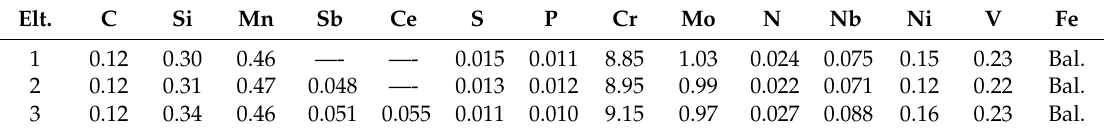
Table 1. Chemical compositions of undoped, Sb-doped, and Sb+Ce-doped steels (wt. %).